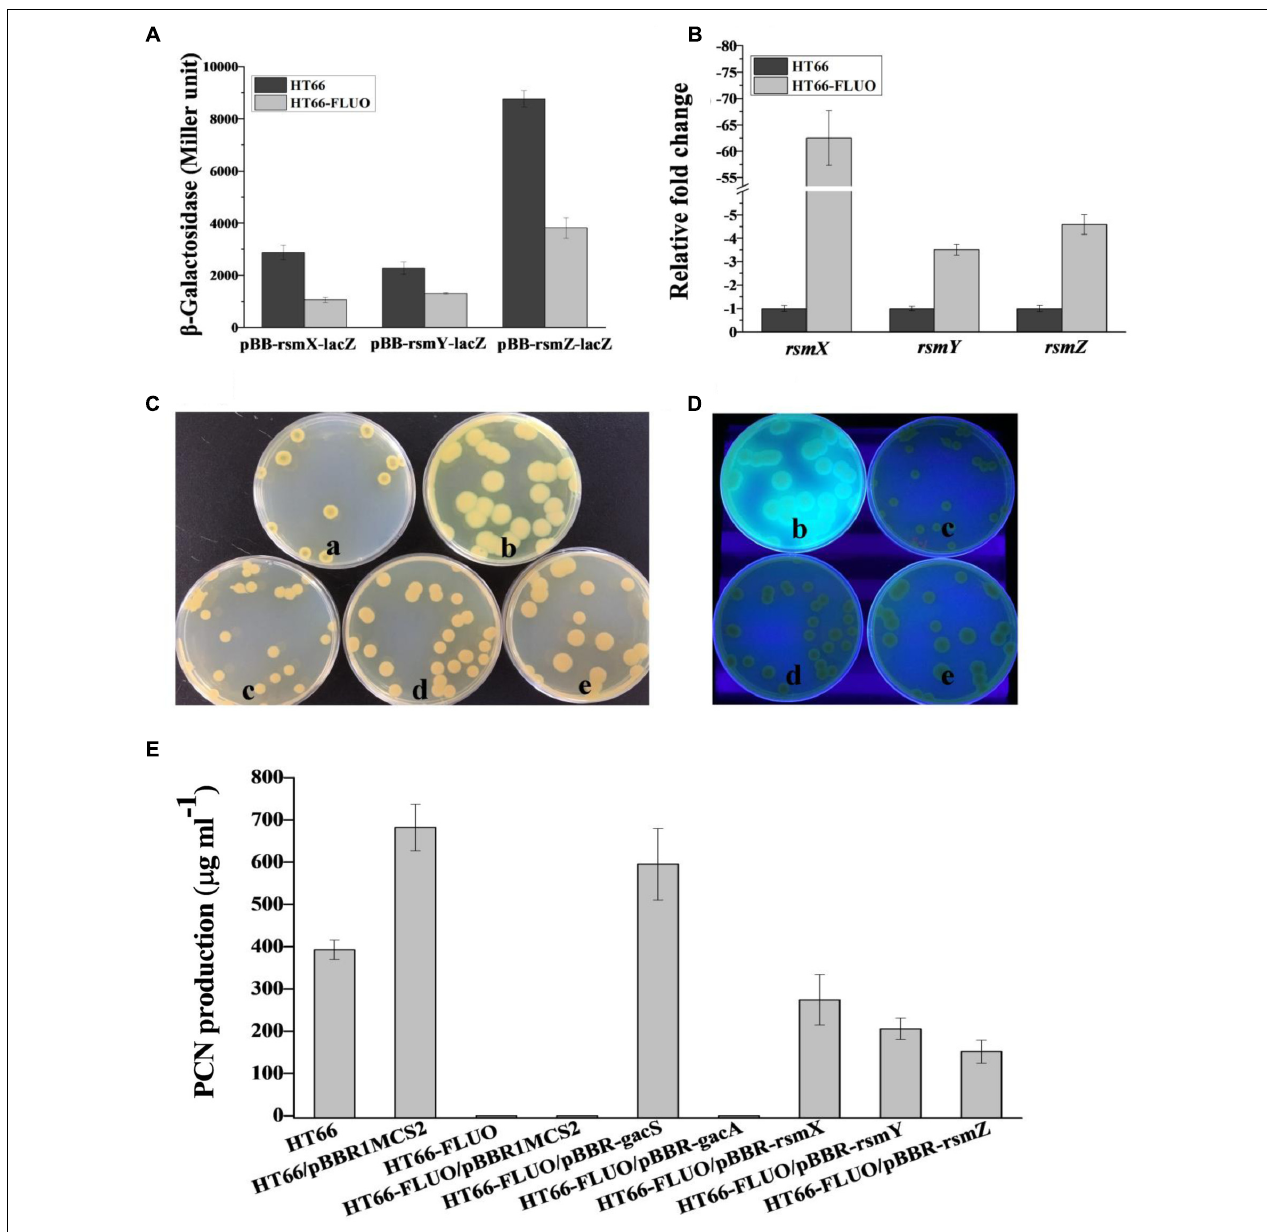
FIGURE 8 | (A) β -Galactosidase measurements were performed on expression from the pBB- rsmX - lacZ , pBB-r smY - lacZ , pBBR- rsmZ - lacZ transcriptional fusion plasmid in the wild-type strain HT66 and HT66-FLUO in KB medium. (B) The transcript levels of rsmX , rsmY , rsmZ in P. chlororaphis HT66 and HT66-FLUO determined by qRT-PCR at logarithmic phase. (C) The morphology and (D) fluorescence phenomenon under UV light of HT66 (a), HT66-FLUO (b), HT66-FLUO/pBBR- rsmX (c), HT66-FLUO/pBBR- rsmY (d), HT66-FLUO/pBBR- rsmZ (e), all the strains were incubated on KB agar plates for 60 h (E) , PCN production was determined using HPLC analysis in KB broth at 28 ◦ C with 180 rpm for 60